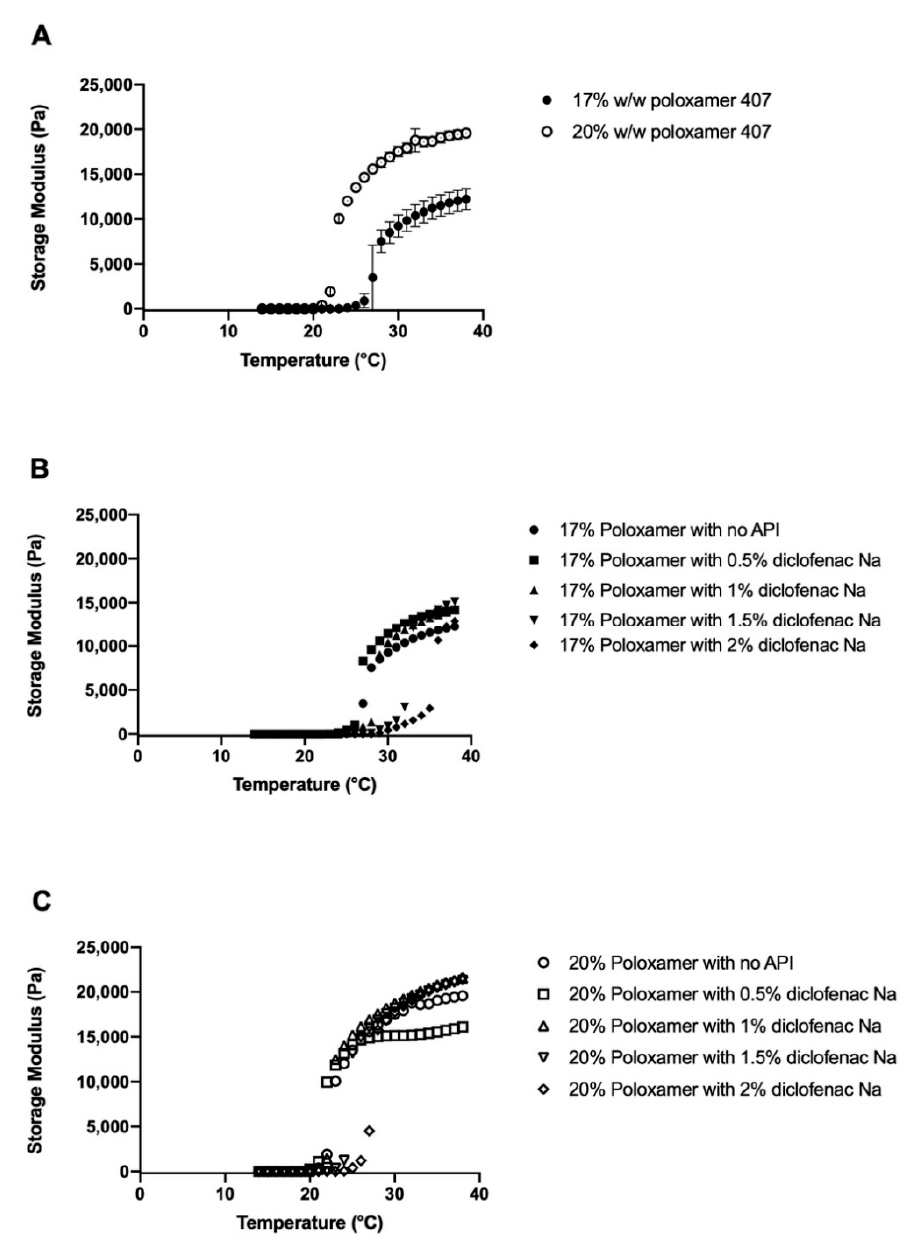
Figure 3. Temperature sweeps from 14 to 38 °C for 17% (filled circles) and 20% (open circles) w/w poloxamer 407 solutions without ( A ) and with ( B , C ) 0–2% diclofenac sodium. Data are presented as mean ± SD ( n = 3). SD error bars are omitted for figure clarity in panels ( B , C ).